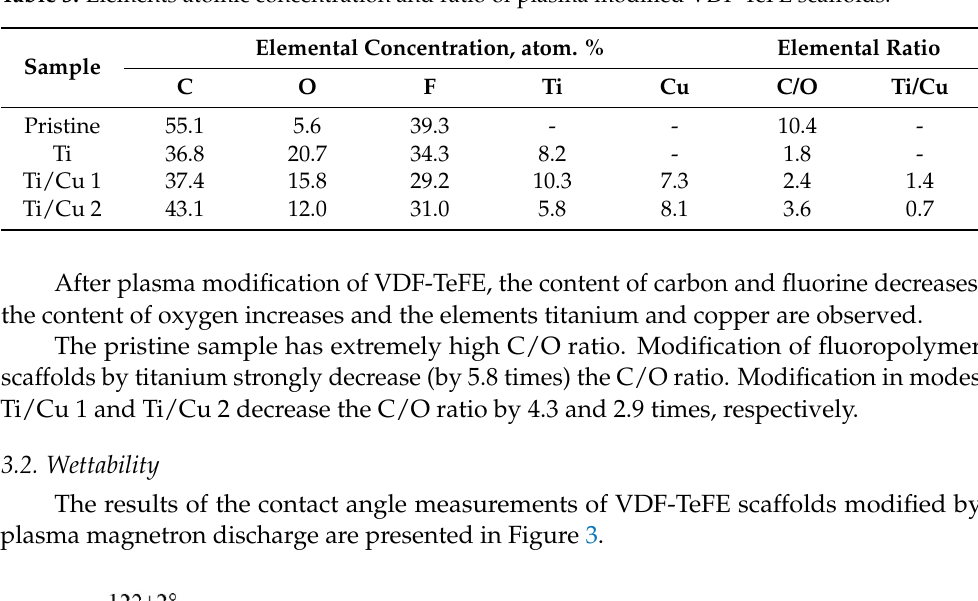
Table 3. Elements atomic concentration and ratio of plasma modified VDF-TeFE scaffolds.